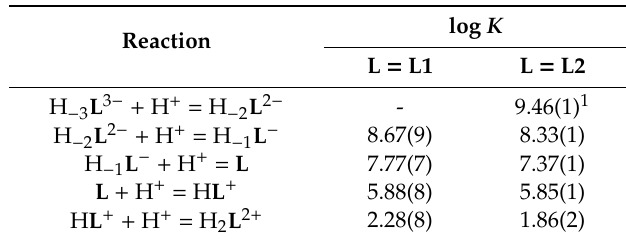
Table 1. Protonation constants (log K ) of L1 and L2 potentiometrically determined in 0.15 mol dm − 3 NaCl and NMe 4 Cl, respectively, aqueous solution at 298.1